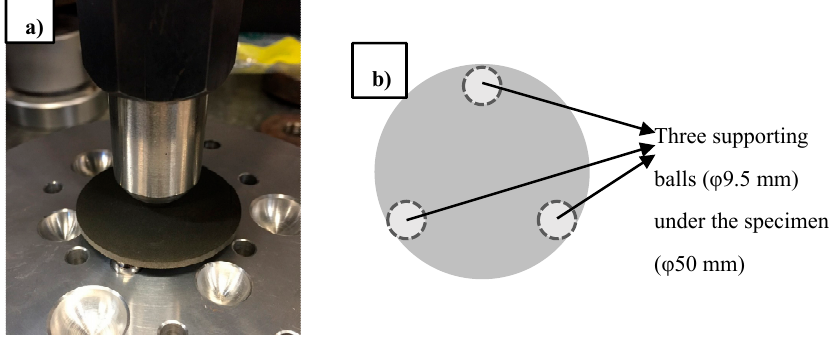
Figure 1. ( a ) Photo of the ball-on-three-ball (B3B) fixture with a specimen; ( b ) top view (dimensions) of the testing setup.